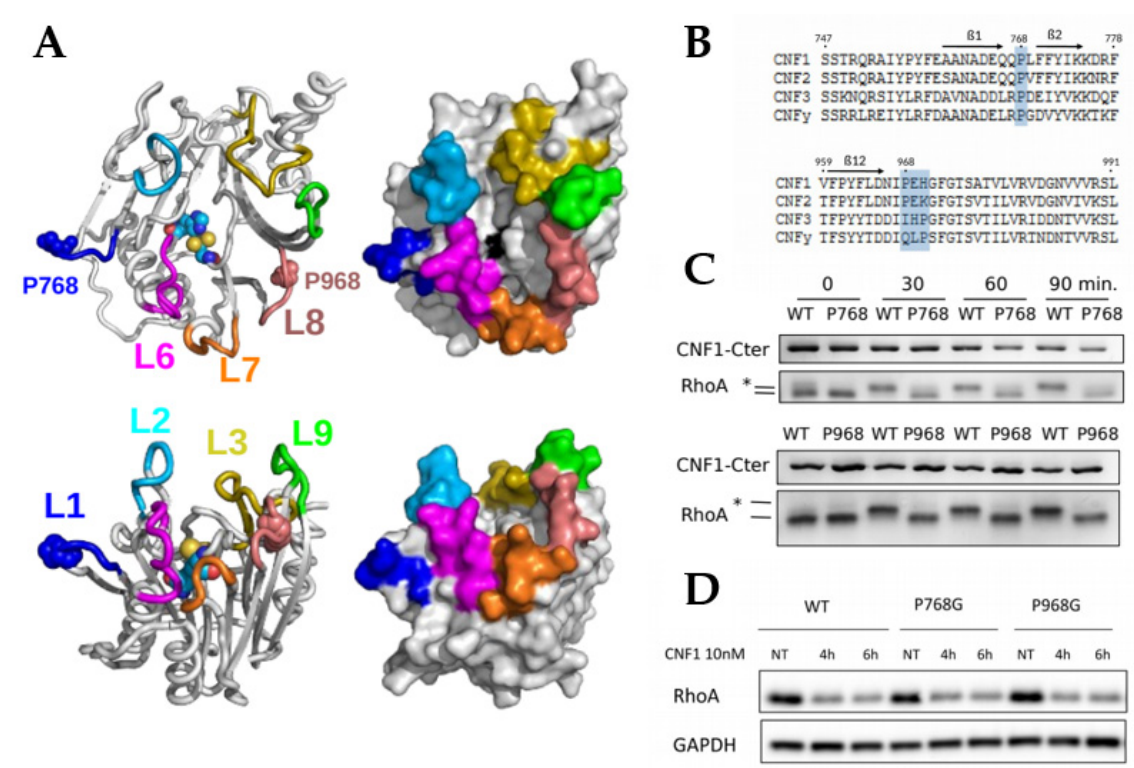
Figure 1. Sequence conservation and functional importance of P768 and P968 residues. ( A ) structure of CNF1 CD . Overview (top) and side-view (bottom) of the X-ray crystallographic structure 1HQ0 [9]. The protein structure is drawn as a cartoon (left) and as a surface (right). The upper loops are colored blue (L1), cyan (L2), yellow (L3), violet (L6), orange (L7), pink (L8), and green (L9). Proline 768 (L1) and 968 (L8) and the catalytic residues C866 and H881 are drawn as spheres. C866 is colored black on the protein surface. The figures were generated using PyMOL [23]. ( B ) Conservation of P768 and P968 among CNF-like factors. Protein sequences of CNF1 (CAA50007), CNF2 (WP057108870), and CNF3 (WP024231387) from E. coli and CNFy (WP012304286) from Yersinia pseudotuberculosis were retrieved from NCBI. The alignment was generated using Clustal Omega [24]. The blue highlight indicates the positions of P768 and P968 in L1 and L8, respectively. ( C ) Altered deamidase activity of CNF1 CD mutants P768G and P968G in vitro. Kinetics of RhoA deamidation by CNF1 CD WT is visualized by monitoring the upper shift of RhoA on SDS-PAGE (*). Upper shift of RhoA is not observed with CNF1 CD P768G and P968G even after 90 min reaction. Figures show representative experiments, n = 3. ( D ) The targeting of cellular RhoA by CNF1 WT and mutants is monitored by following the toxin-induced proteasomal degradation of the GTPase. Immunoblots show efficient degradation of RhoA in cells intoxicated by CNF1 WT, P768G and P968G, one representative experiment, n = 3. Immunoblots anti-GAPDH show equal protein loading. HUVECs were left untreated or intoxicated 4 and 6 h with 10nM of CNF1 WT and mutants (NT: non-treated). Targeting of RhoA by CNF1 is monitored by following the toxin-induced proteasomal degradation of the GTPase.